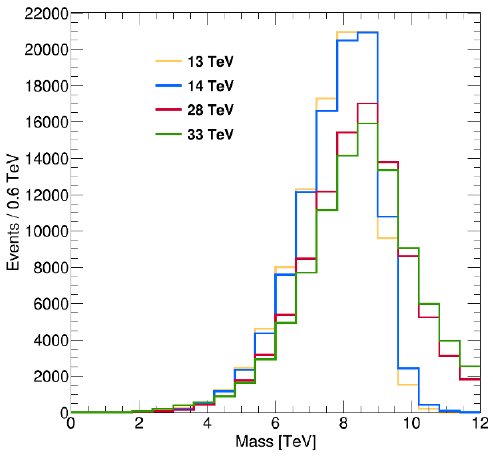
Figure 3 . Invariant-mass distributions of observable (cid:12)nal-state particles in simulated LHC colli- sions at 13, 14, 28, and 33 TeV. These simulations are made with the nominal E Sph = 9